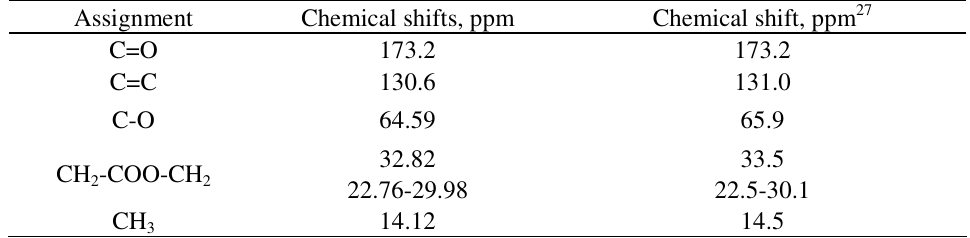
Table 3. The main signals present in 1 H-NMR functional groups of oleyl oleate